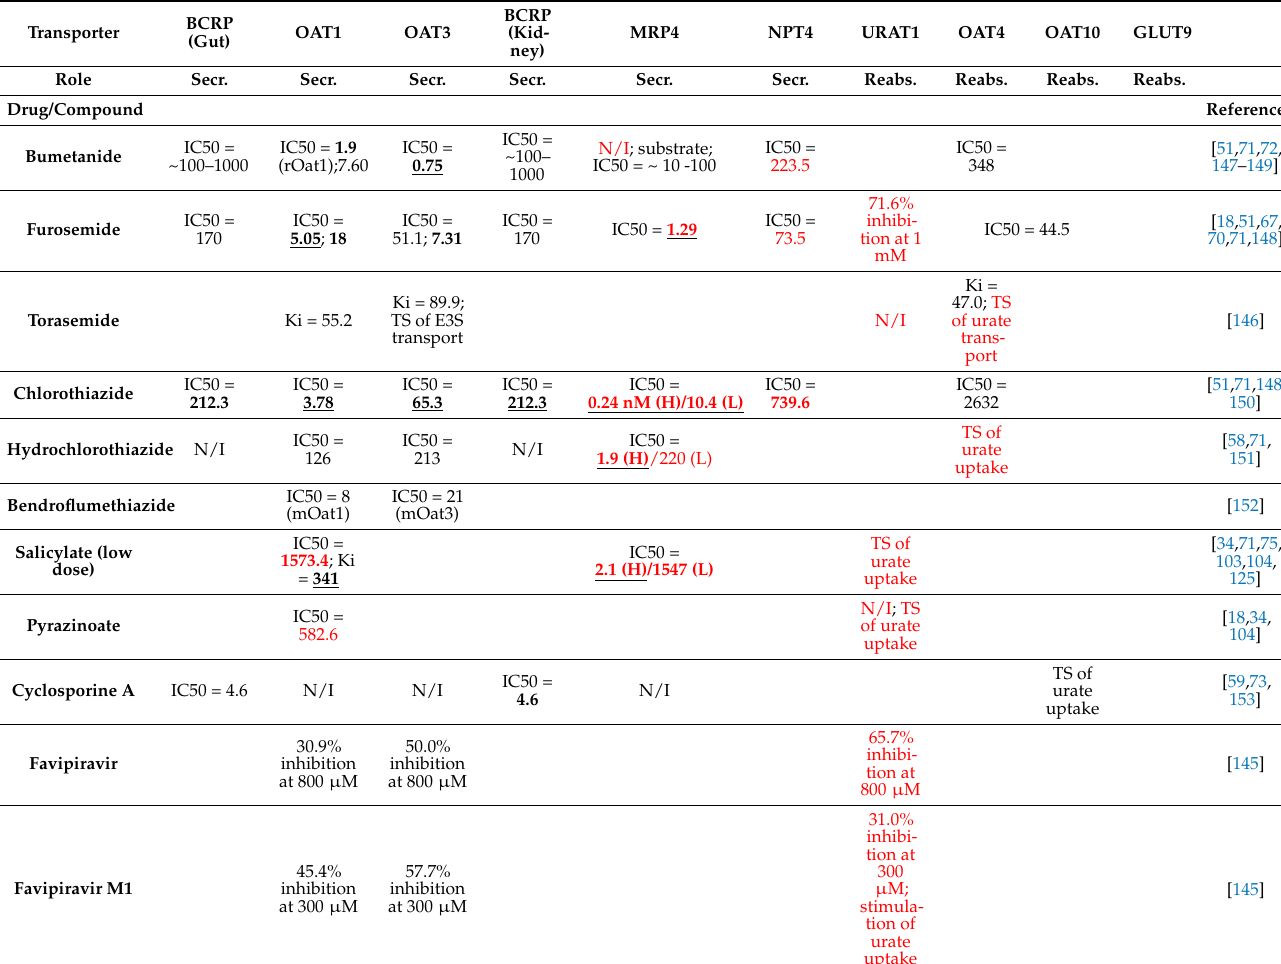
Table 5. Transporter interaction profile of hyperuricemic agents. For each drug/transporter pair, results from different studies are separated by semicolons. All values are in µ M unless noted otherwise. N/I, no inhibition; TS, trans-stimulation; (H)/(L), high/low affinity transport. The rules for highlighting in bold or bold and underlined are the same as in Table 3. Values in red were obtained using urate as a probe substrate. Abbreviations: Secr., secretion; Reabs.,